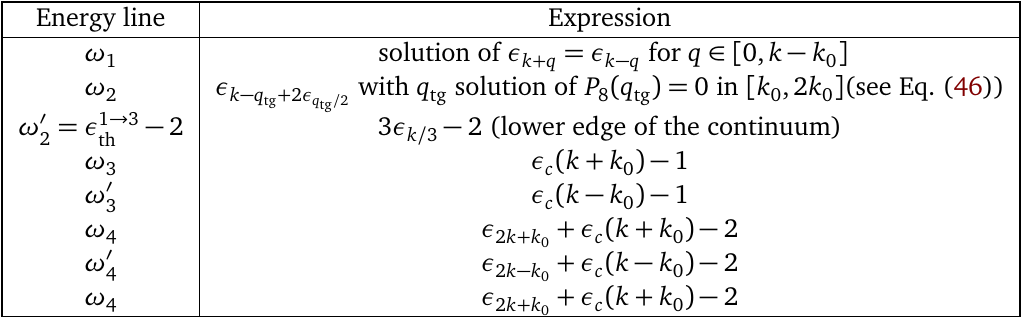
Table 6: Energy lines separating the resonance superconfigurations in Fig. 13.